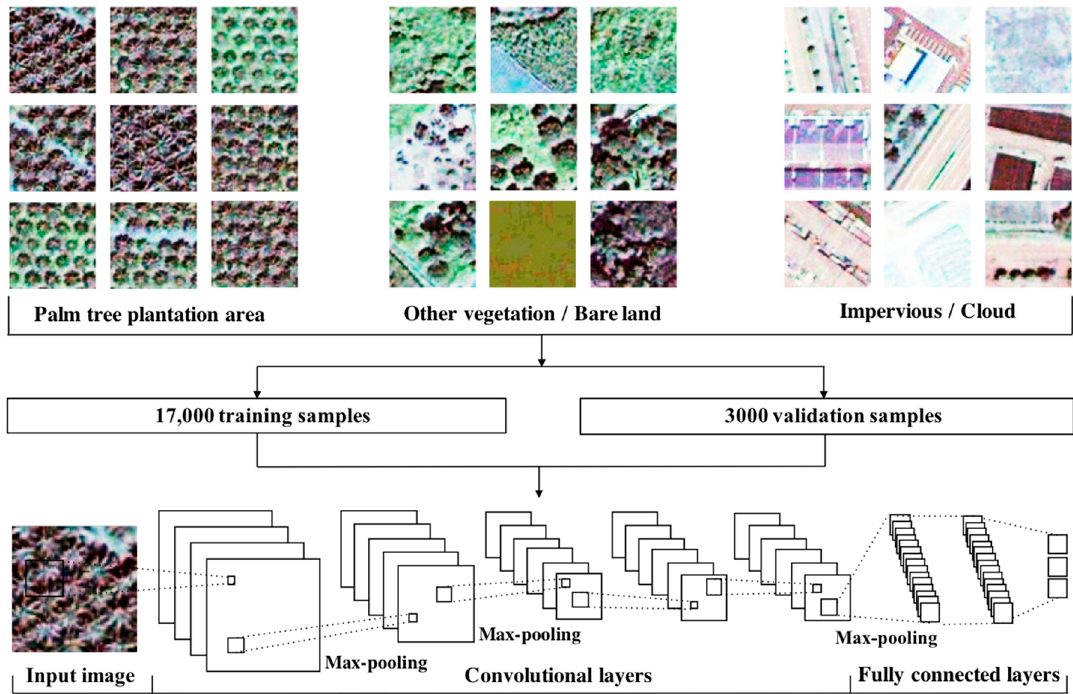
Figure 3. The framework of the CNN for land-cover classification.